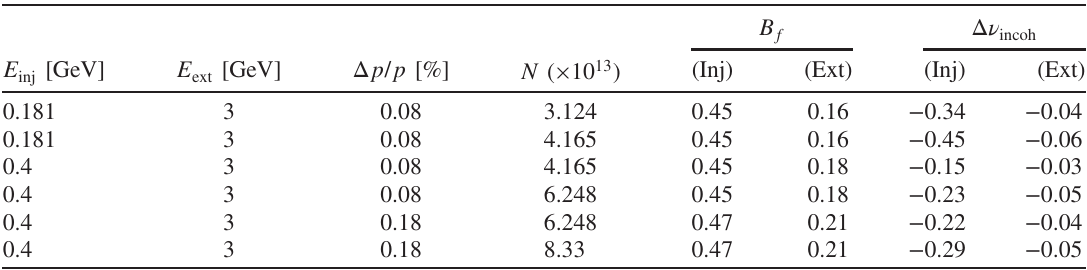
TABLE II. Incoherent tune shift Δ ν at injection and extraction energies estimated by using Eq. (1) for the incoh beam intensities considered in the present study. The measured rms momentum spreads ( Δ p / p ) of the injected beam used in the simulations are also given. B